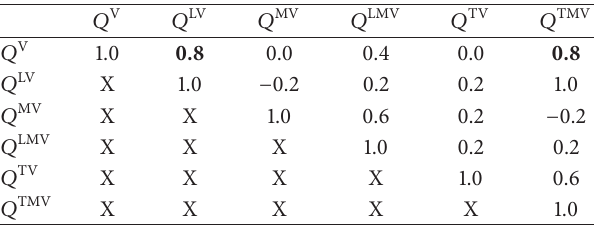
Table 17: Kendall rank correlation between different